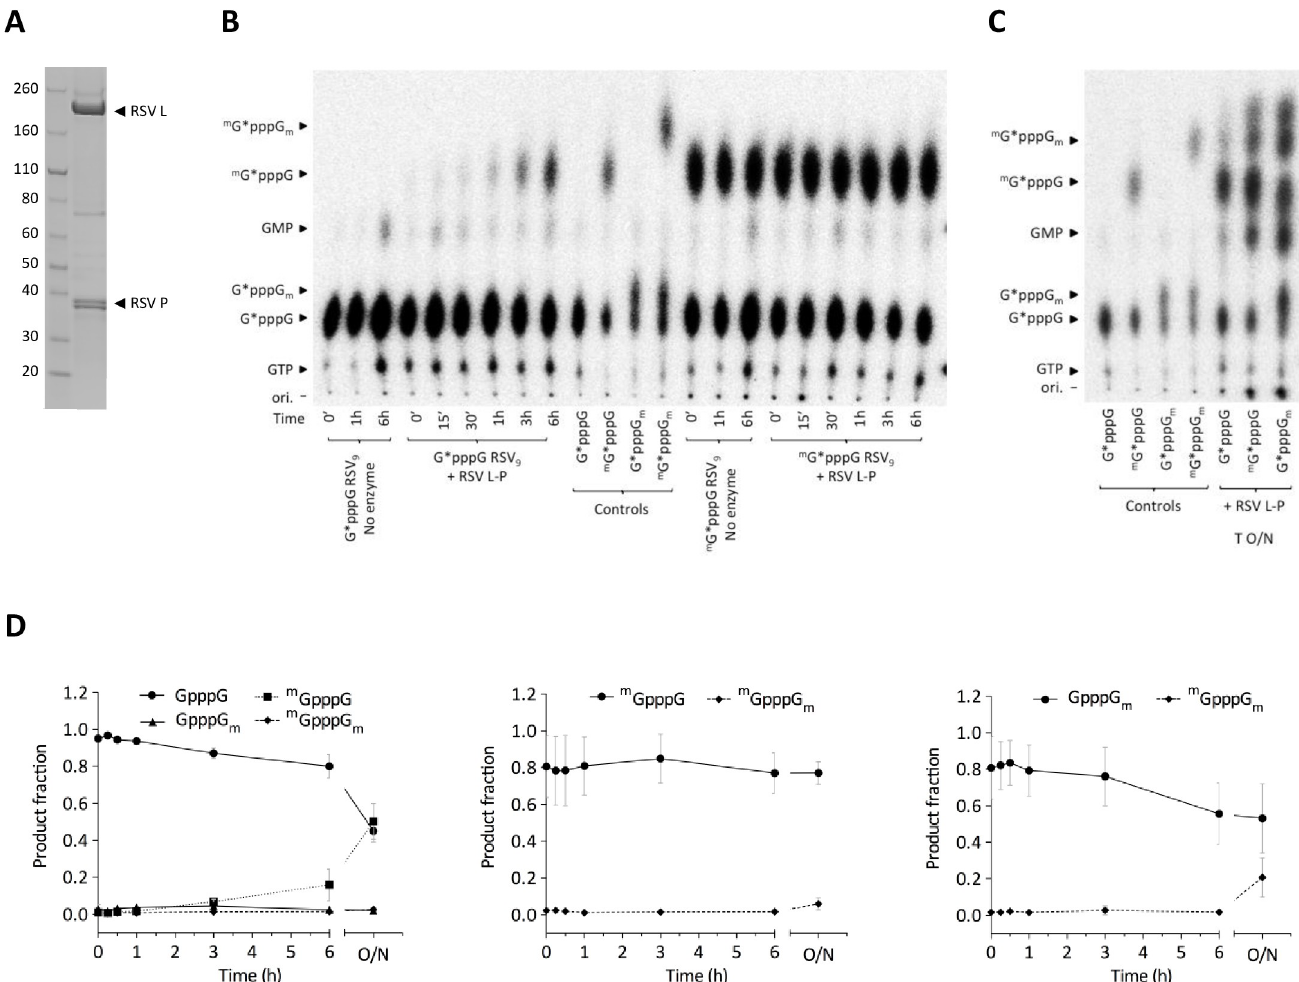
Fig 6. MTase activity of the RSV L-P complex. ( A ) SDS-PAGE of the purified RSV L-P complex. Molecular weights (in kilodaltons) of the ladder are shown on the left, and the L and P bands are labeled on the right. ( B ) Time-course analysis of methylation by thin-layer chromatography of the cap structures of control RNAs and substrates (G � pppG and m G � pppG) incubated with RSV L-P ( � indicates G( 32 P)-labeled) for up to 6 h at 30˚C. ( C ) After overnight (O/N) incubation, nucleotides 2–9 were removed by nuclease P1 digestion and caps were separated using 0.65 M LiCl as mobile phase. Controls (G � pppG, G � pppG m , m G � pppG, m G � pppG m ) were obtained using the pppG-RSV 9 substrate and vaccinia virus MTases that specifically methylate caps at the N7 or 2’- O positions. The RSV L-P complex was used at the concentration of 100 nM. ( D ) Densitometry quantitations of TLC analysis expressed as a ratio of the substrate consumption (G � pppG (left), m G � pppG (middle), G � pppG m (right)) and product formation over time. Values are the mean ± SEM (n = 3).